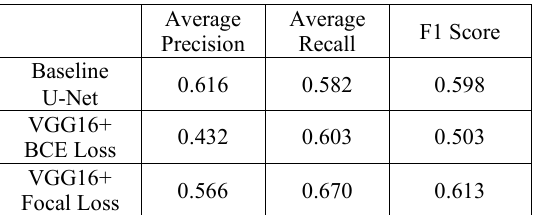
Table 3. The comparison between three models.